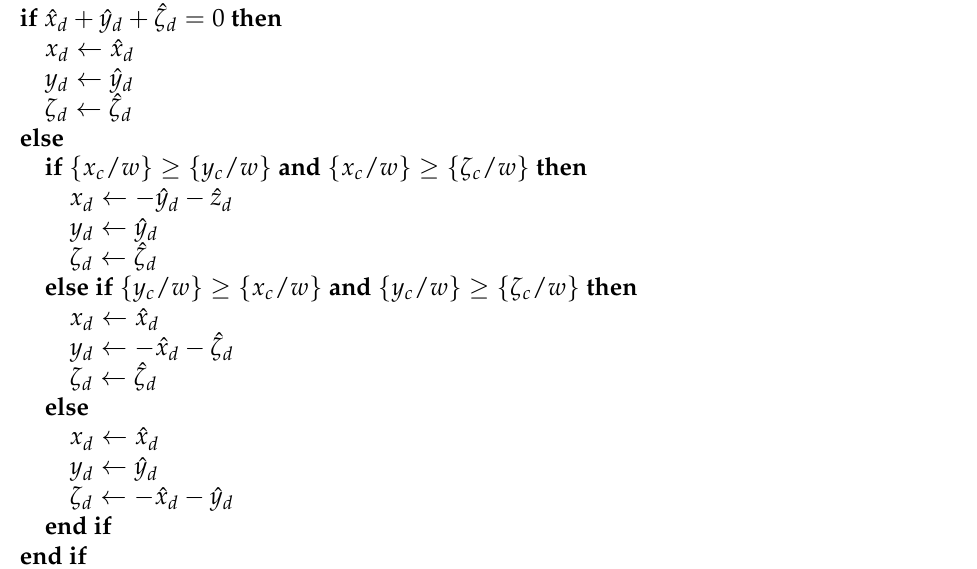
Algorithm 1 Discretization of Hexagonal